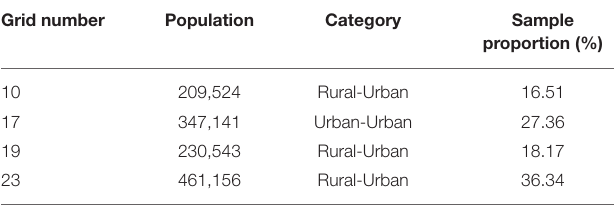
TABLE 1 | Grid-wise proportionate sampling